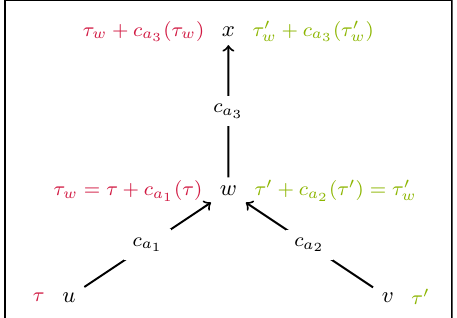
Figure 1. Graph corresponding to the Dyn-MOSP instance discussed in Examples 1 and 2. The corresponding arc cost functions are shown in Figure 2.